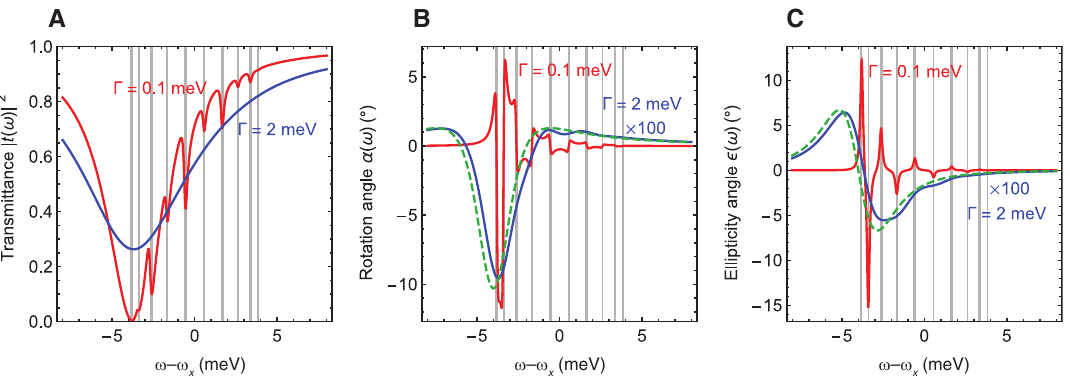
Figure 4: Optical properties of chiral stacks with N = 10 layers. (A) Transmittance | t ( ω ) | 2 , (B) polarization rotation angle α ( ω ), and (C) ellipticity angle ε ( ω ). Vertical lines indicate the frequencies of eigen exciton modes. Red and blue curves are calculated for the stacks with low and high nonradiative decay rates of excitons. Parameters are the same as in Figure 2. Dashed green curves in Figure 4B and C are plotted after analytical Eq. (31) and correspond to the limit of thick stacks or high nonradiative decay